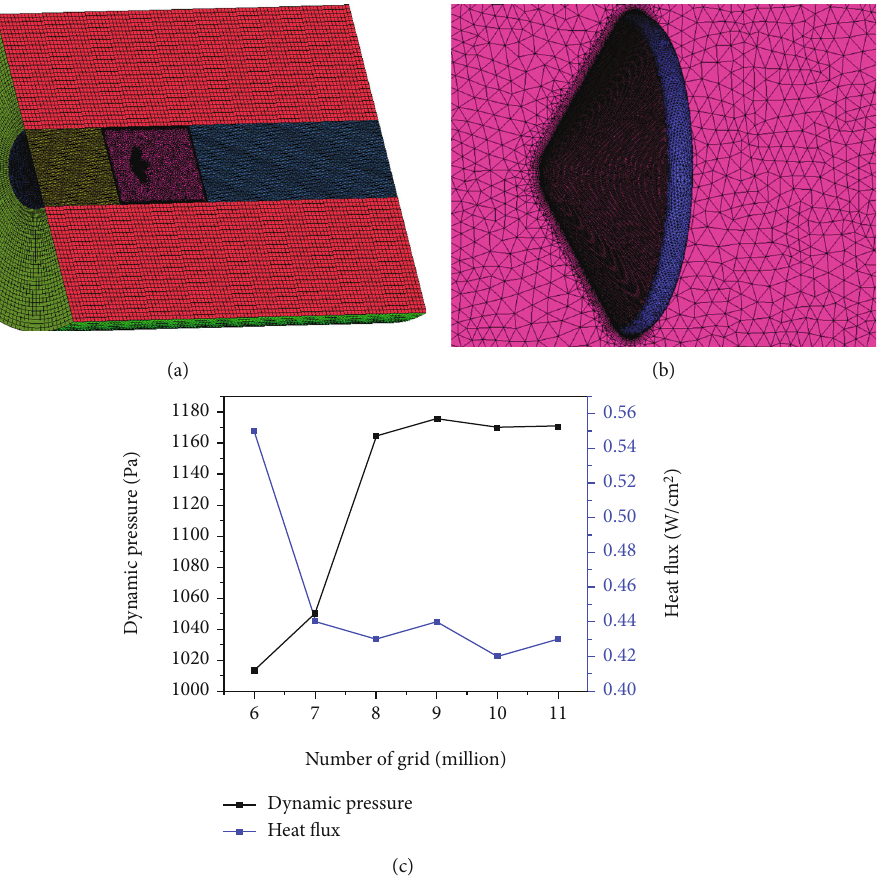
Figure 6: CFD model and validation: (a) sectional view of fl uid domain; (b) mesh near the structure; (c) validation of grid